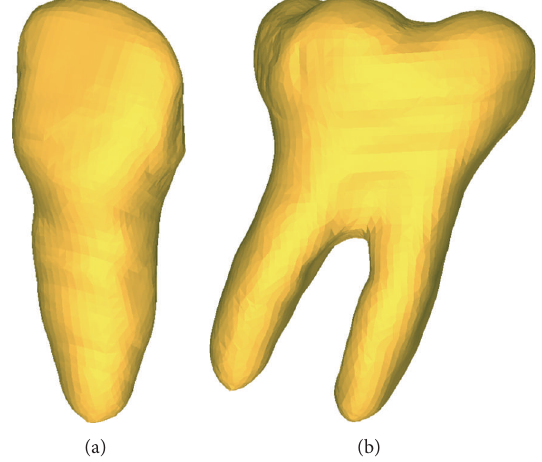
Figure 5: (a) Monoradicular tooth (2.1) segmented and extracted from CBCT. (b) Multiradicular tooth (3.6) segmented and extracted from CBCT.